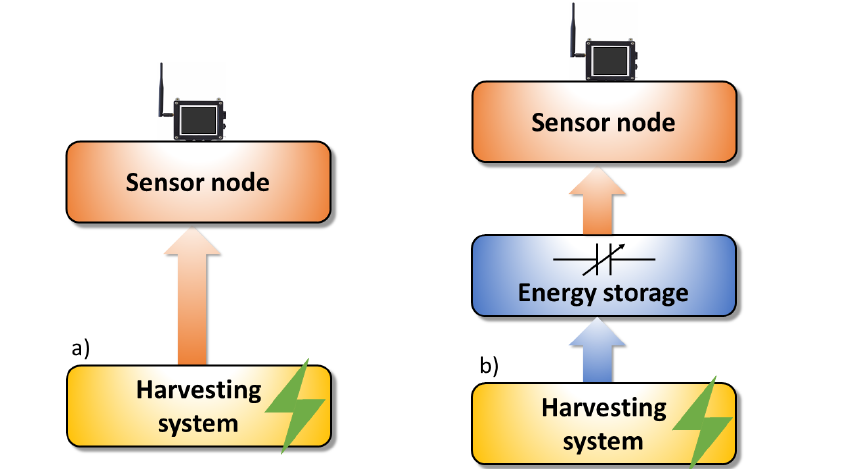
Figure 8. Energy harvesting usage ( a ) use after harvesting ( b ) use from storage (adapted from